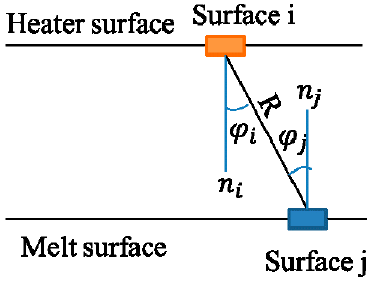
Figure 7. Diagram of the radiation model.